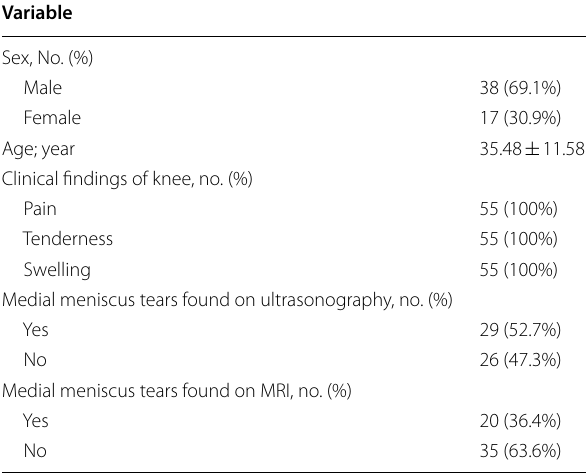
Table 1 Basic characteristics of the patients in this